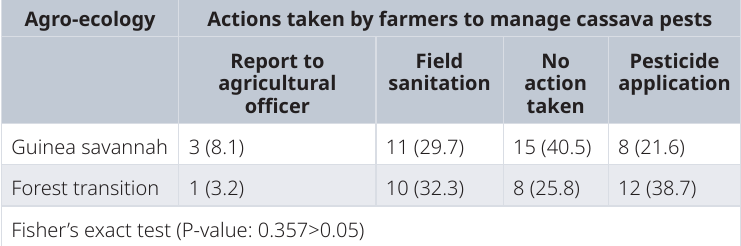
Table 11. Fisher’s exact test for cassava pest management practices by agro-ecology.